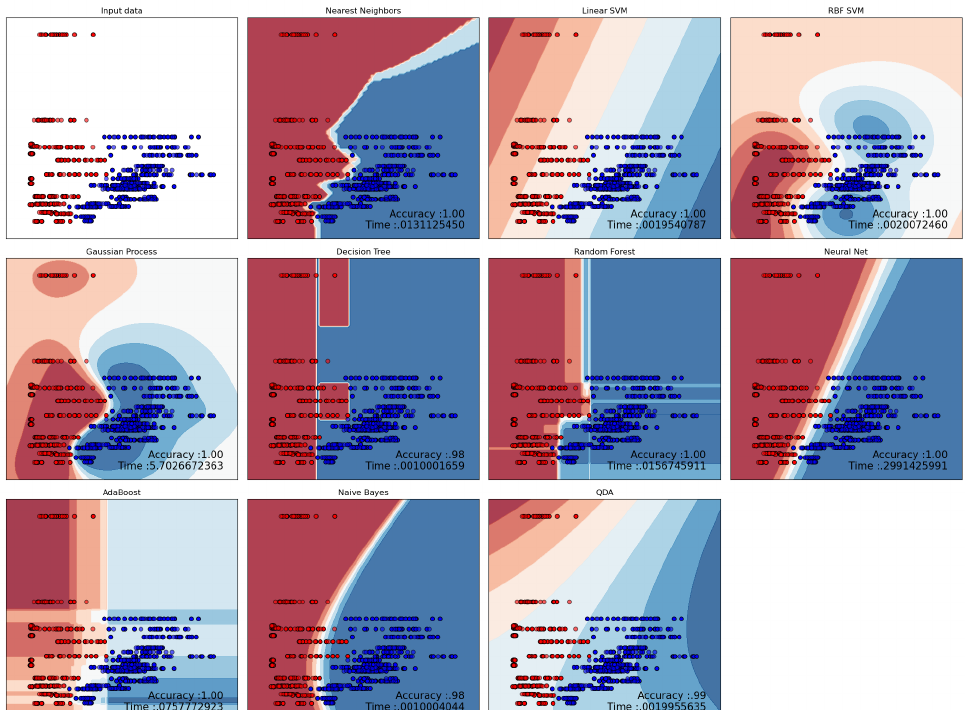
Figure 6. Input Data ( ExM ) value and weight values visualization of the two classes ( Coal in blue and gangue in Red), training and testing of “Nearest Neighbors”, “Linear SVM”, “RBF SVM”, “Gaussian Process”, “Decision Tree”, “Random Forest”, “Neural Net”, “AdaBoost”, “Naive Bayes”, and “QDA” with the decision boundaries display, classification accuracy in a scale of (0–1) and time in seconds.